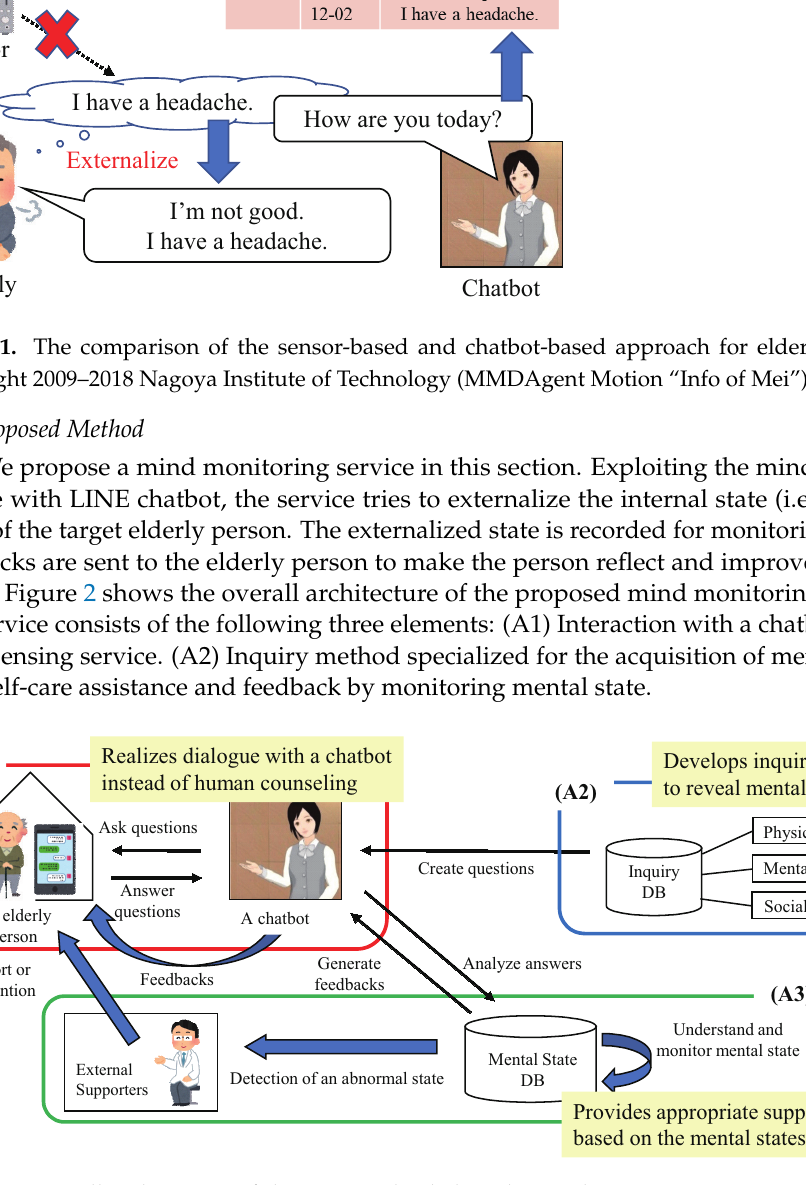
Figure 2. Overall architecture of the proposed rule-based virtual caregiver system using mobile